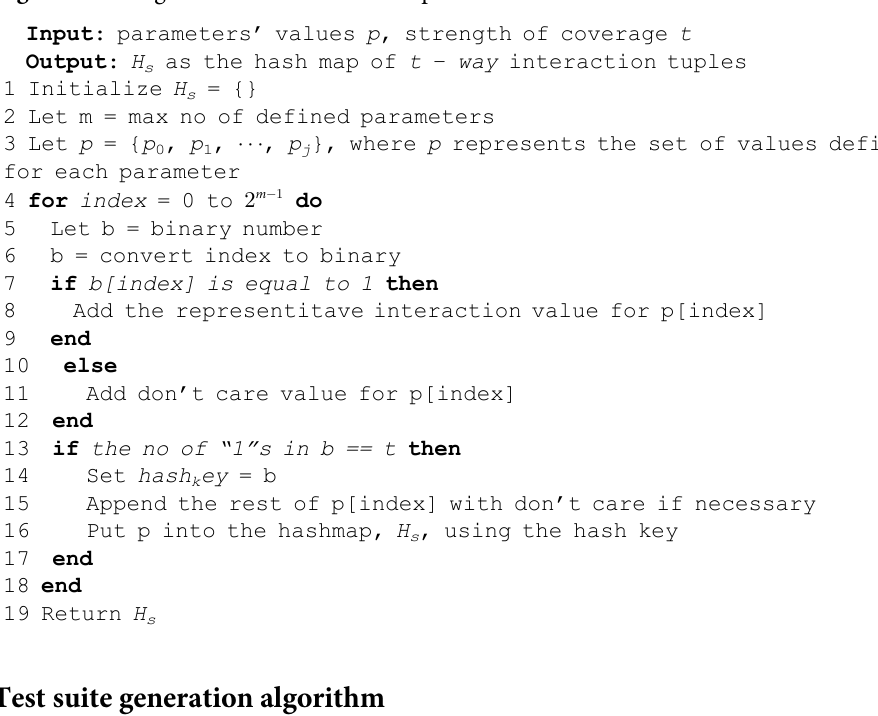
Algorithm 4 : Algorithm for Interaction Tuples Generation